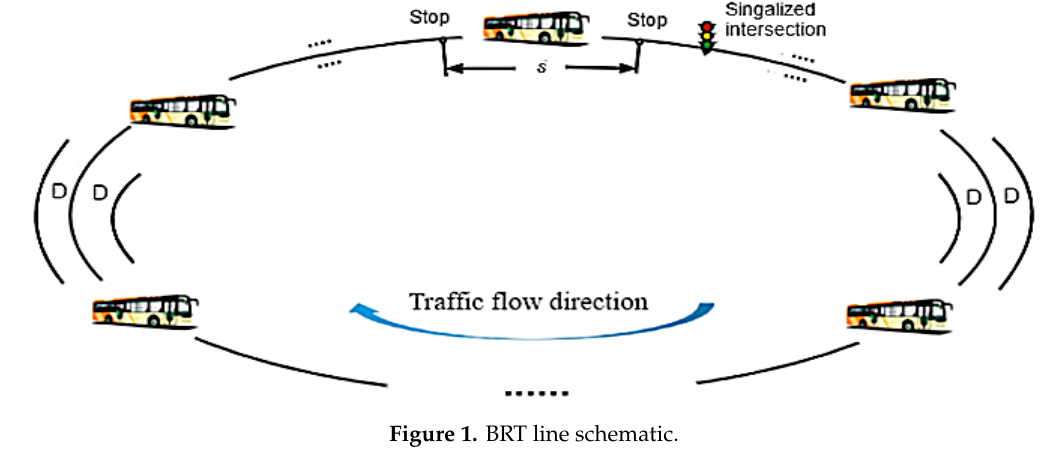
Figure 1. BRT line Figure 1. BRT line schematic. Table 1. Variables and parameters.